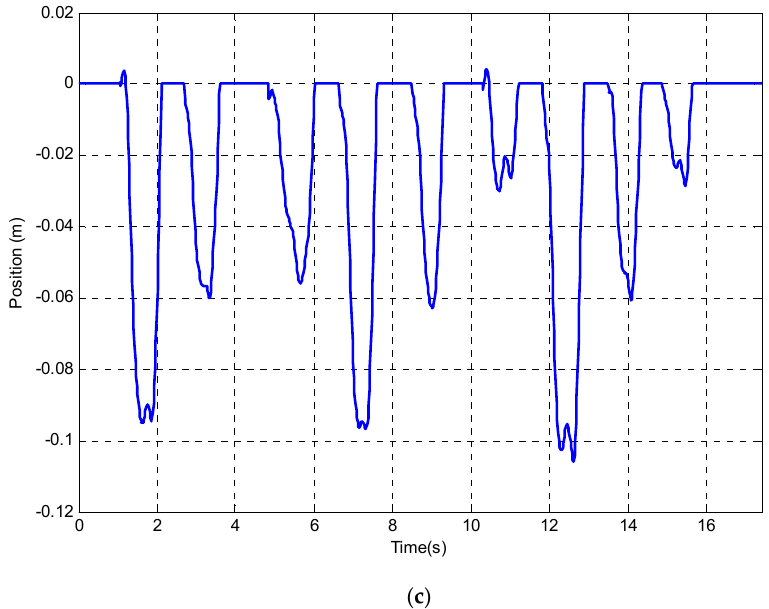
Figure 12. Comparison of hand position tracking by using DR (with and without ZUPT correction). ( a ) Velocity integrated from acceleration before and after ZUPT. ( b ) Position tracking before and after ZUPT. ( c ) Position tracking after ZUPT.